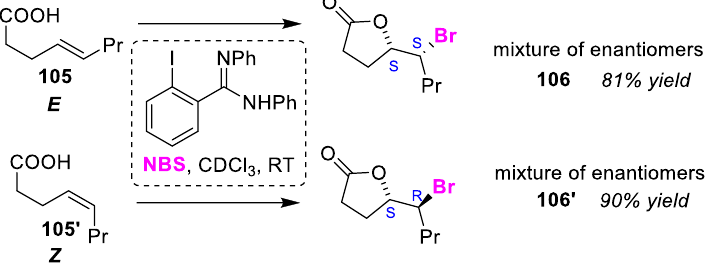
Figure 50. Stereoselective bromo-lactonizations of E -olefinic and Z -olefinic acids ( 105 and 10 5′ ) using o -amidinyl-substituted iodobenzene as an organocatalyst.